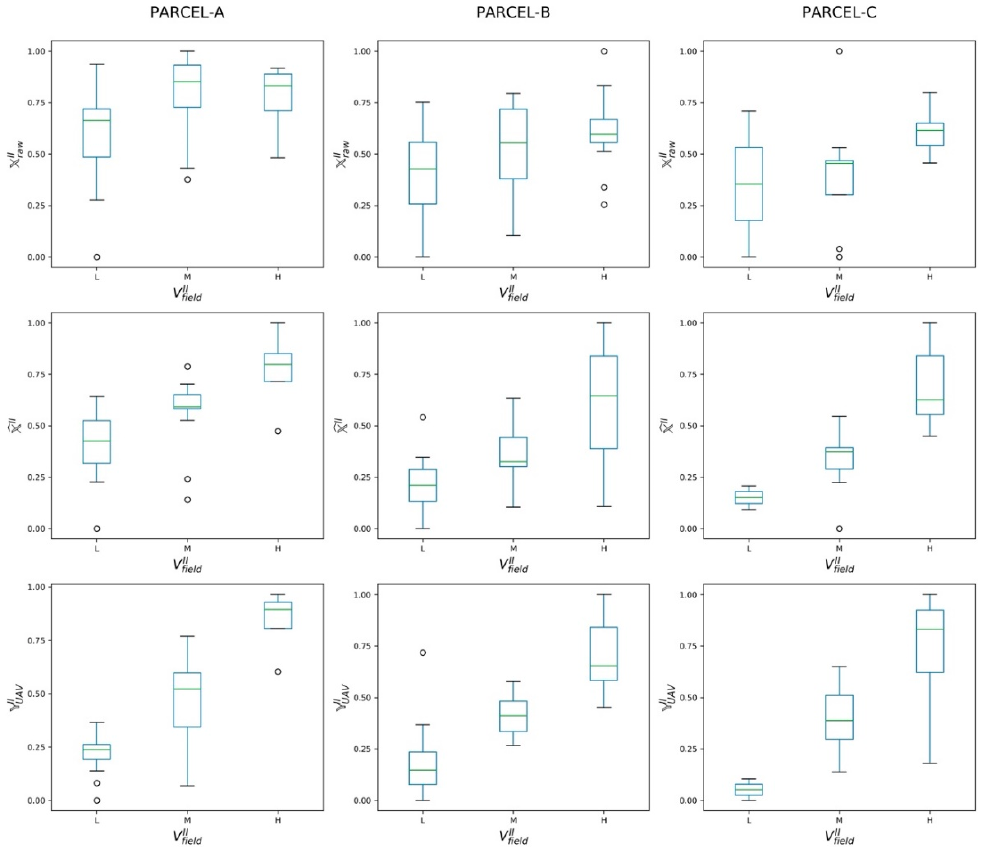
Figure 4. Pixel groups boxplots from raw satellite-driven map 𝑋 (cid:3045)(cid:3028)(cid:3050)(cid:3010)(cid:3010) , refined satellite-driven map 𝑋(cid:3552) (cid:3010)(cid:3010) , and UAV-driven map 𝑌 (cid:3022)(cid:3002)(cid:3023)(cid:3010)(cid:3010) , clustered according to the three vigor classes “L”, “M”, and “H” defined in map 𝑉 (cid:3033)(cid:3036)(cid:3032)(cid:3039)(cid:3031)(cid:3010)(cid:3010) . The boxplots are individually computed for each parcel ( A , B , and C ).